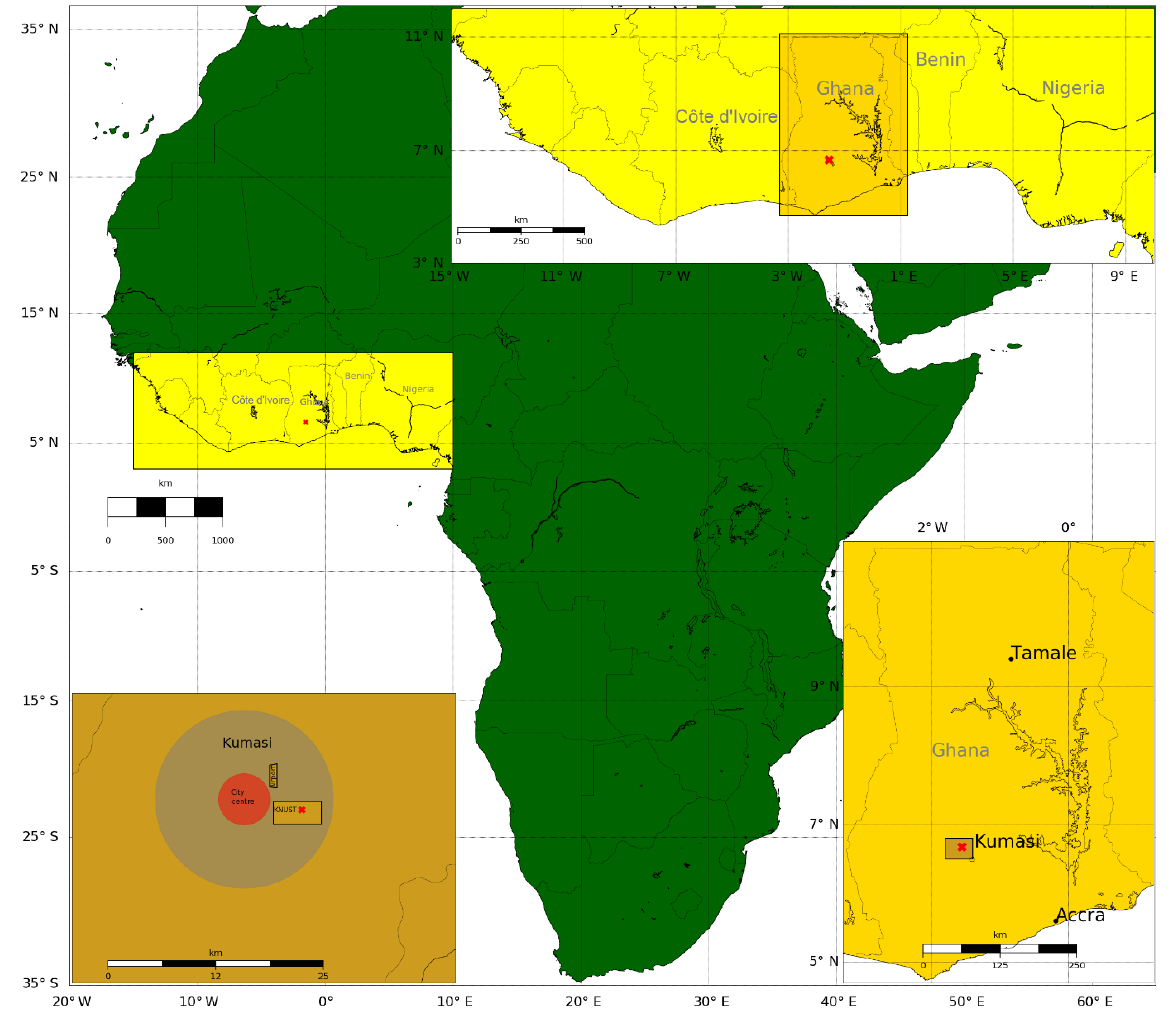
Figure 1. Location of the field site with respect to Africa, the West African region, Ghana, and Kumasi. Table 1. Summary of key physical characteristics of the RS41 and the Windsond S1H2 (based on Table 5 from Vaisala, 2014; SparvEmbed- ded,